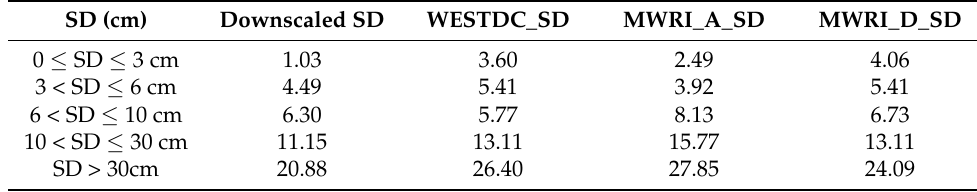
Table 4. RMSE of four types of snow depth datasets for NX under different value levels.